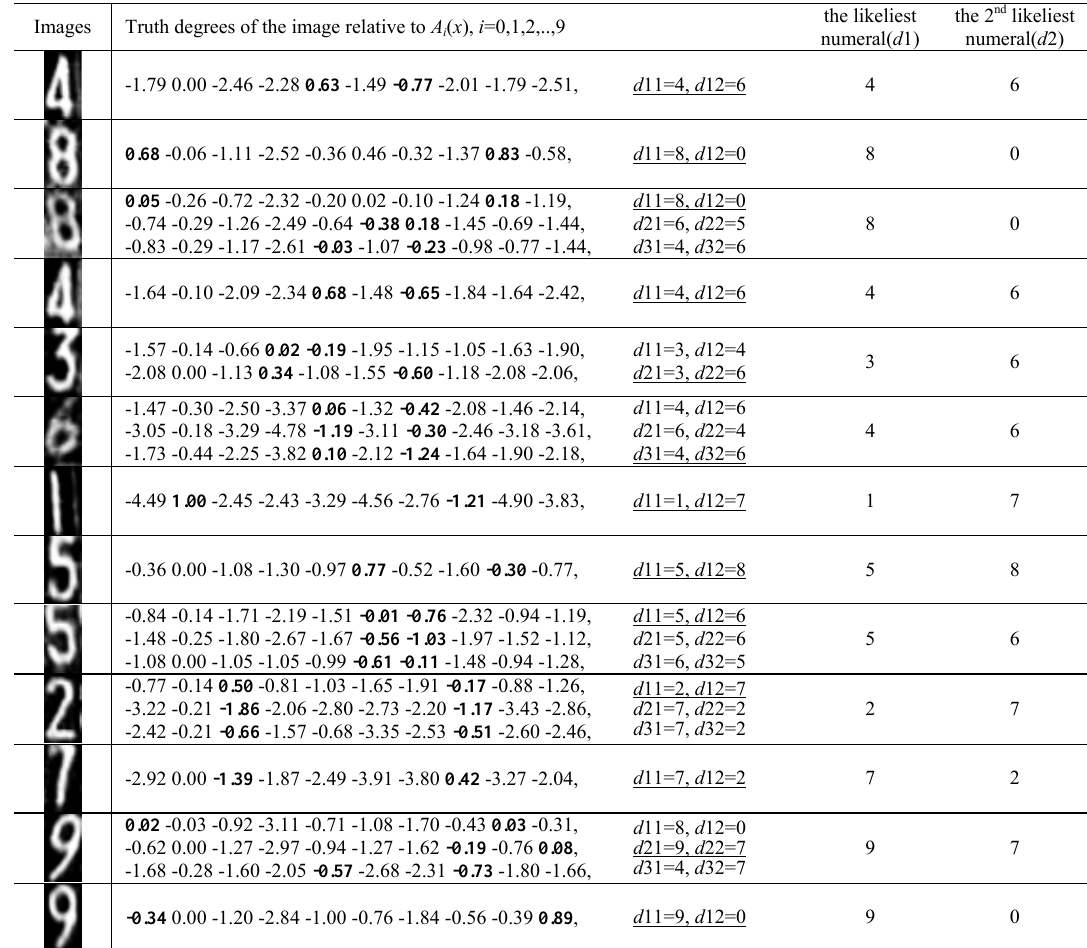
Table 2. Comparisons of recognition accuracy Numeral